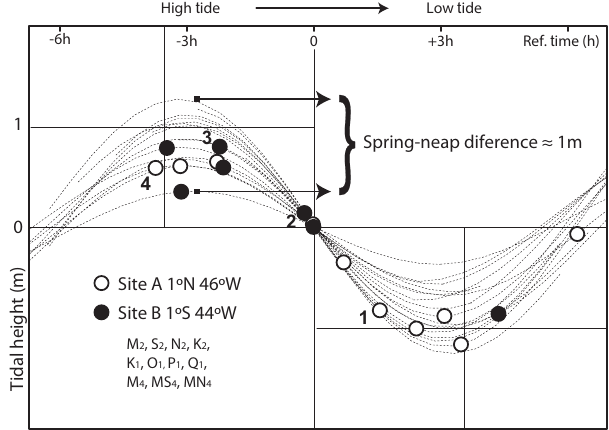
Figure 2. Semi-diurnal and fortnightly tidal phases for all dates and times listed in Table 1 (each corresponding to an image acquisition), using the tidal constituents listed in the bottom-left corner, and com- puted correspondingly at locations A and B (represented by white and black circles, respectively). Note that, for a meaningful compar- ison, the time running in the horizontal direction is with reference to the transition between high tide and low tide (i.e. when tidal heights change sign), and differences in the vertical range concern different phases of the spring–neap